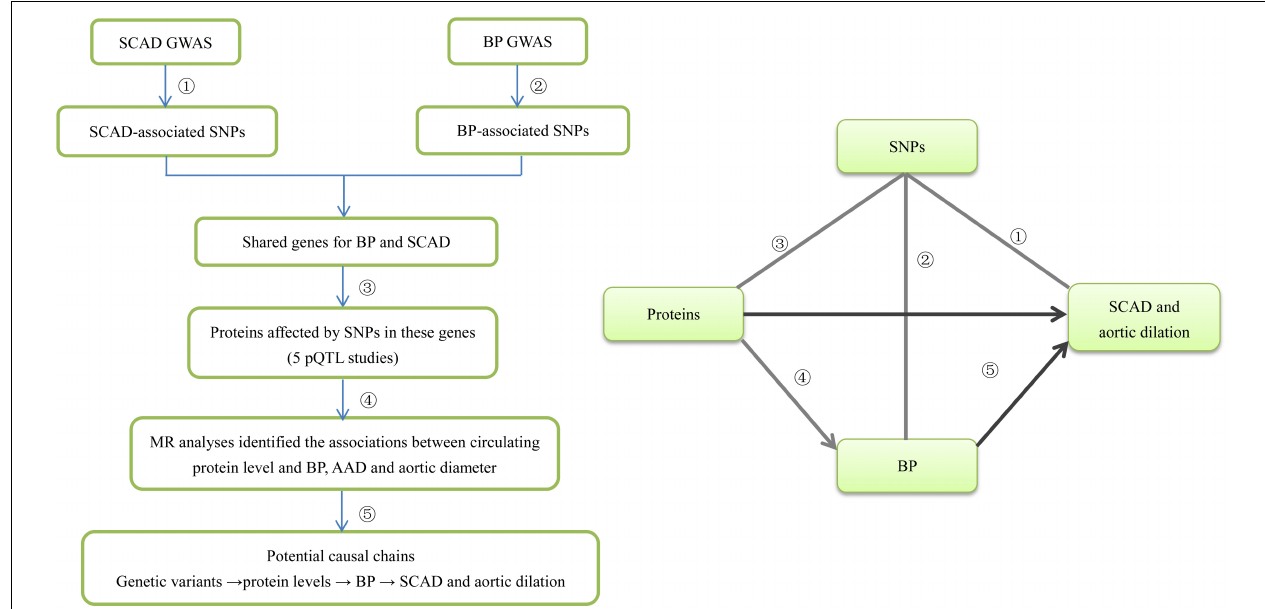
FIGURE 1 | The flowchart of the study design. We designed this study to explore potential risk factors such as circulating proteins for SCAD. This study comprised several steps of analysis. In the first step we identified SCAD-associated genes from five GWASs. Second, we identified BP-associated SNPs in the SCAD-associated genes from BP GWAS and then identified the shared genes for BP and SCAD. Third, we looked for pQTLs inside these genes using data from five pQTL studies. Fourth, for circulating protein levels that were significantly affected by both SCAD-associated and BP-associated SNPs, we applied four MR methods (IVW, MR-Egger, MR-PRESSO, and CAUSE) to examine whether they were genetically associated with BP, AAD, and aortic diameter. Finally, we inferred that genetic variants influence BP by disturbing circulating proteins, and then affecting the risk of SCAD and aortic